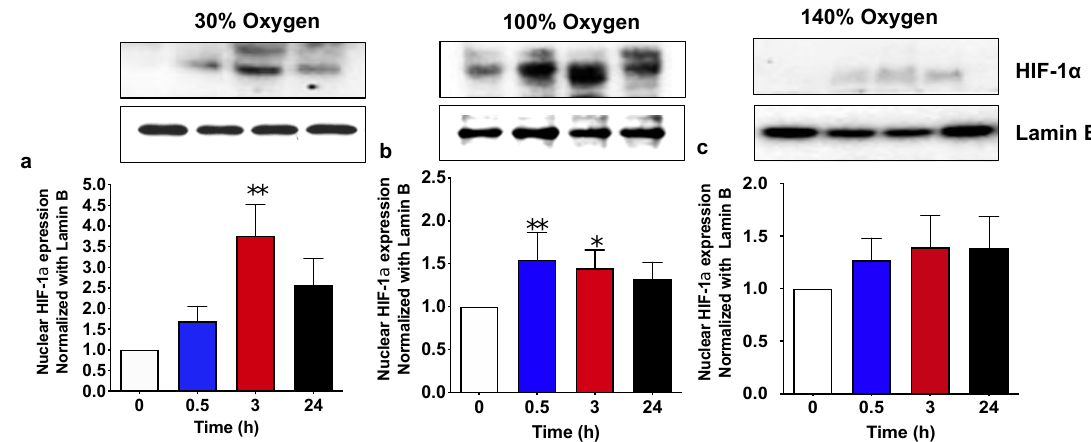
Figure 1. HIF-1α nuclear translocation following 1 h hyperoxia. ( a ) Mild hyperoxia (30% O 2 ); ( b ) high hyperoxia (100% O 2 ); ( c ) very high hyperoxia (140% O 2 ) before and after the recovery to normoxic conditions. Above histograms, the picture shows a representative western blot analysis. Results are expressed as fold change (mean ± SEM) in comparison to baseline (0), which was set at 1. * p < 0.05, ** p < 0,01; for one-way ANOVA followed by Dunnett’s post hoc test.